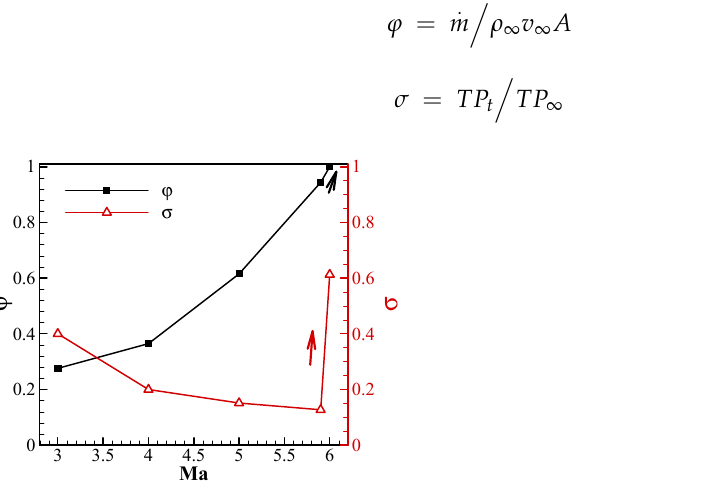
Figure 7. Distributions of the mass flow ratio and total pressure recovery coefficient during the first type of starting process ( δ = 3°).